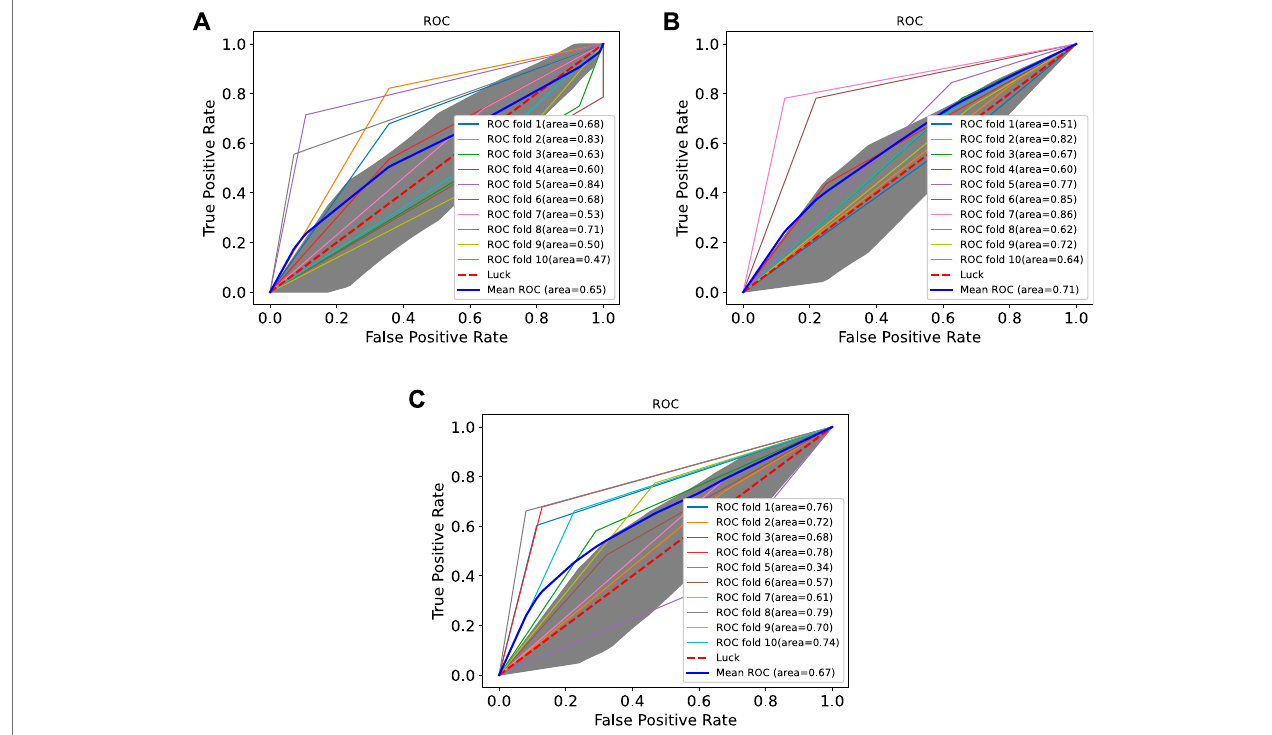
FIGURE 9 | ROC curves on three datasets using LR. ROC, receiver operating characteristic; LR, logistic regression.